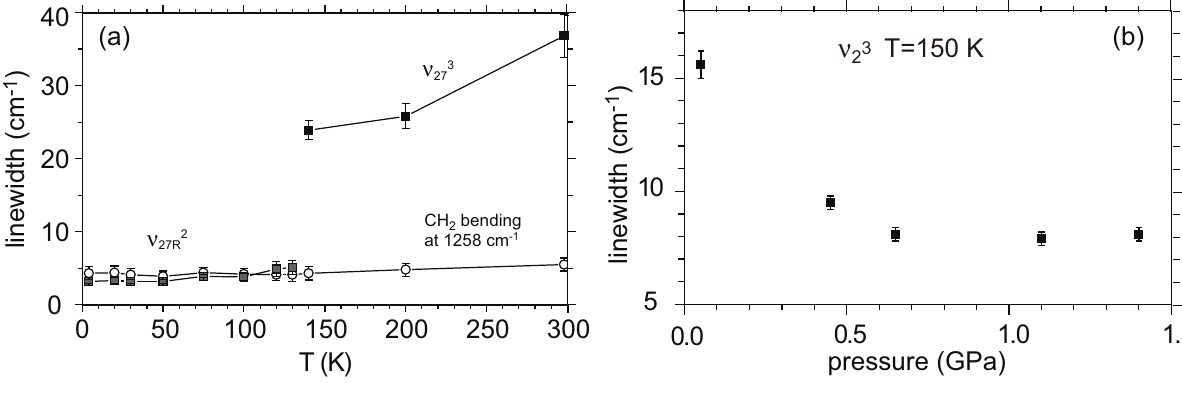
Figure 21. The linewidth of ν of the linewidth of infrared-active ν ( b ) Pressure dependence of the linewidth of Raman active ν 23 , which decreases